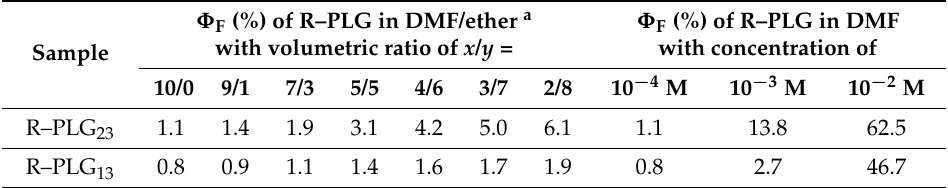
(Figure S7) for both systems of R–PLG 23 and R–PLG 13 . Higher aggregation level in more concentrated solution is responsible for the emission enhancement here.